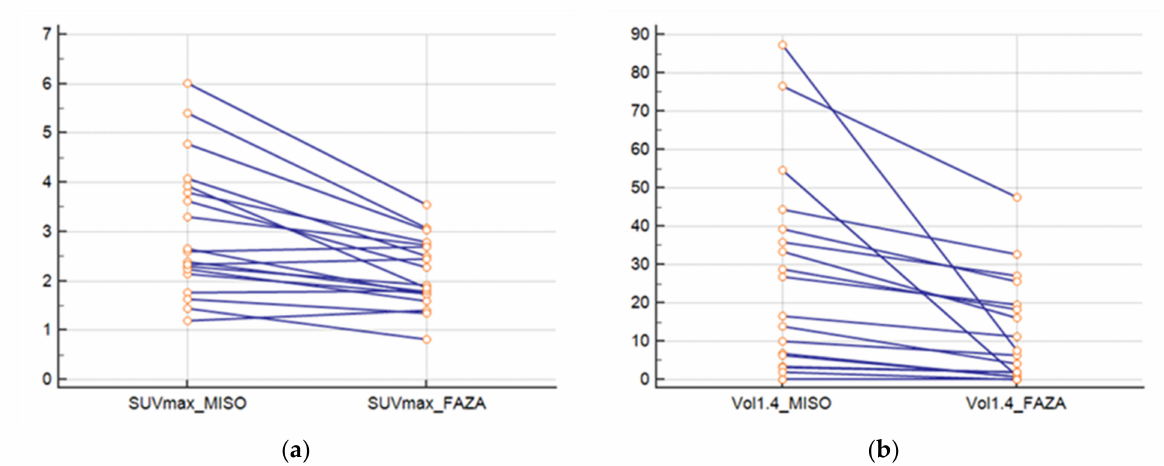
Figure 2. ( a ) SUVmax of lesions for FAZA and FMISO and ( b ) volumes of lesions with FAZA and FMISO (threshold at 1.4).